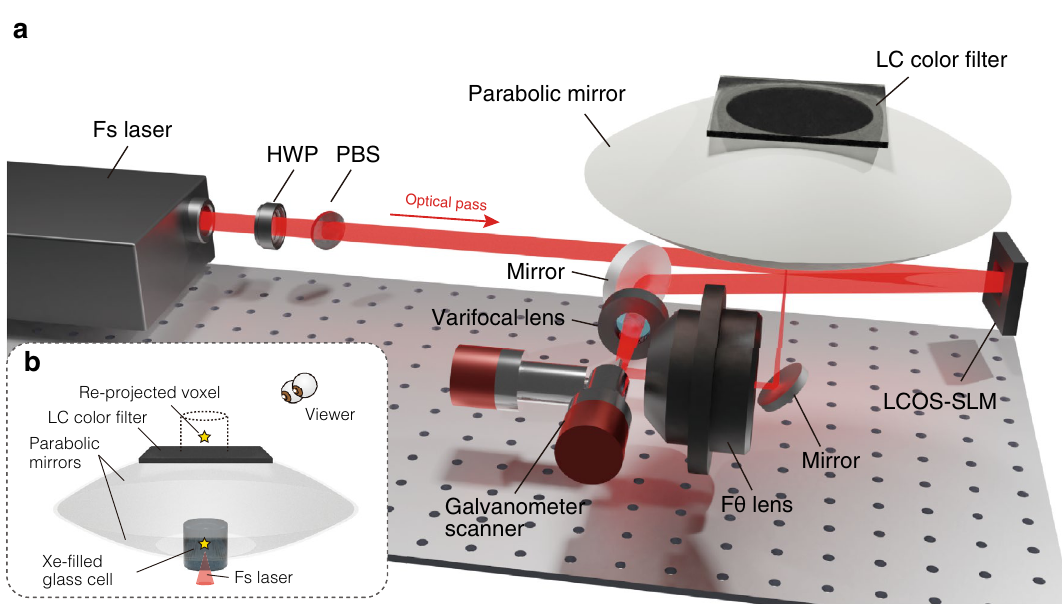
Figure 4. Design of a volumetric display system based on DSS. ( a ) A femtosecond-laser-excited emission point is spatially scanned in an aperture on the bottom parabolic mirror by a beam scanning system and enhanced by a CGH on an LCOS-SLM. A half-wave plate (HWP) and a polarization beamsplitter (PBS) are used to control pulse energy of the femtosecond laser. The photograph of the actual system is shown in the Supplementary Fig. 2. ( b ) The emission point is generated as a voxel in the viewing space by the re-projection system, and its emission brightness is enhanced by the introduction of a glass cell filled with Xe gas. This figure was created using Blender version 2.91 (https:// www. blend er.